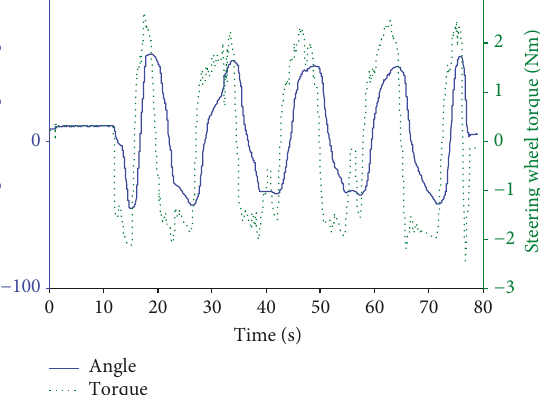
Figure 26: Vehicle speed of road test.